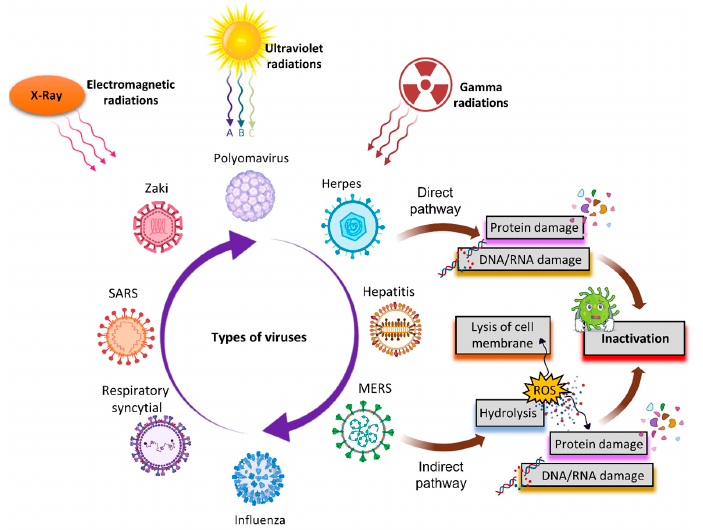
Figure 1. The illustration of the direct and indirect impacts of several types of radiation on microor- ganisms. 3. Virus Deactivation Using Emerging Nonthermal Biocompatible Plasma (NBP)